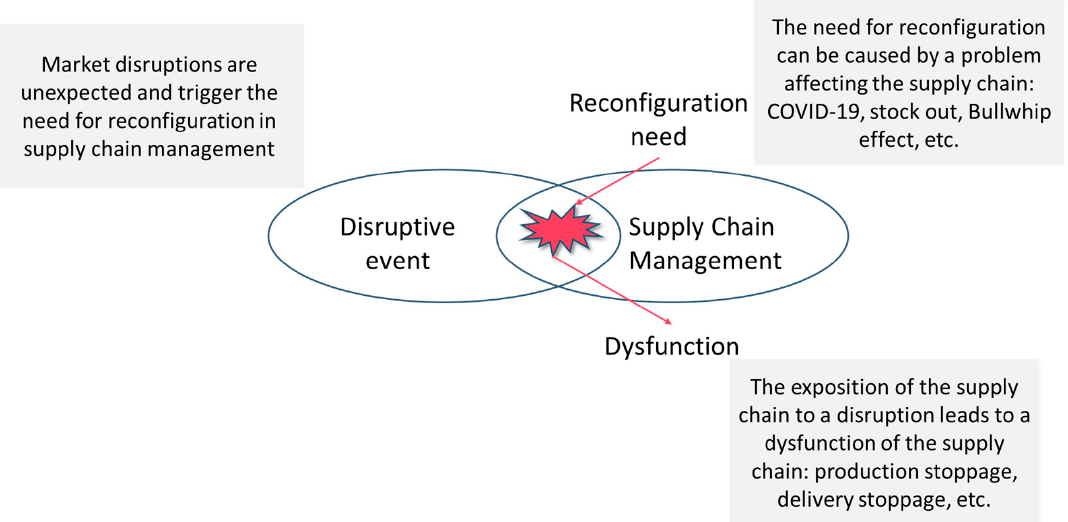
Figure 2. Impact of the disruptive event on supply chain management.